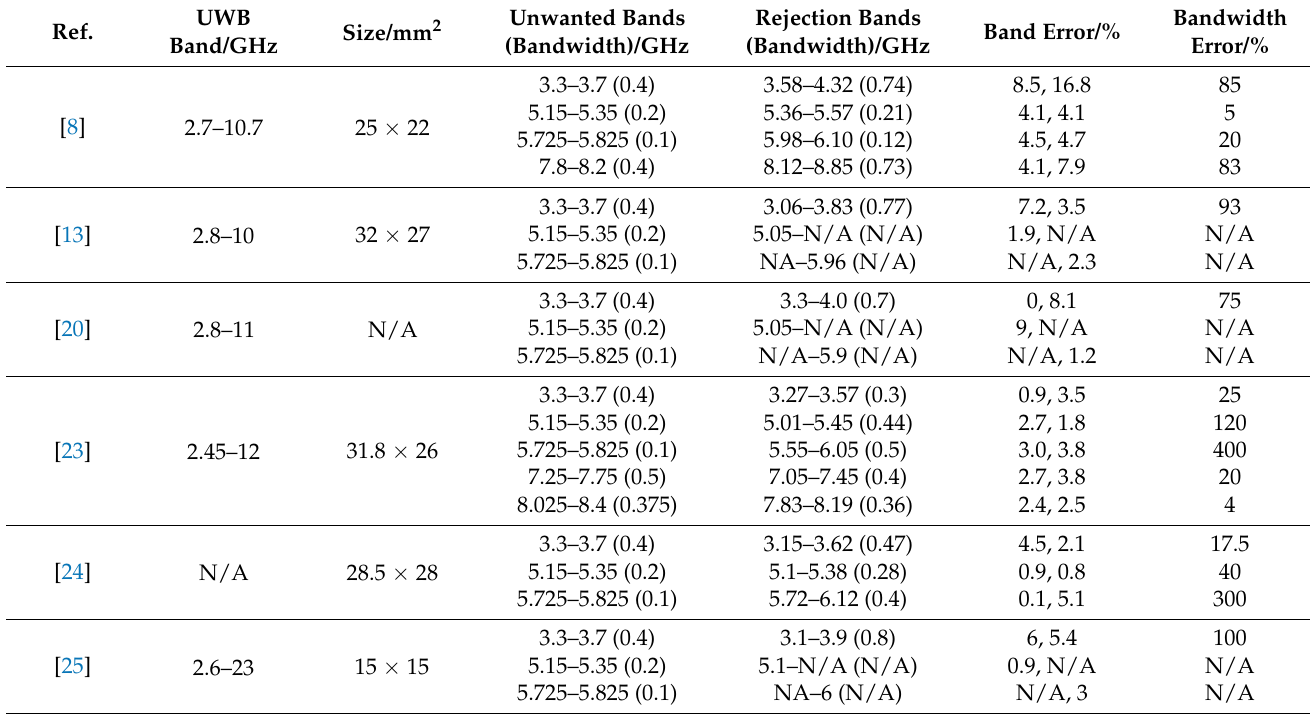
Table 2. Comparison of proposed and reference antenna about unwanted bands and achieved rejection bands.